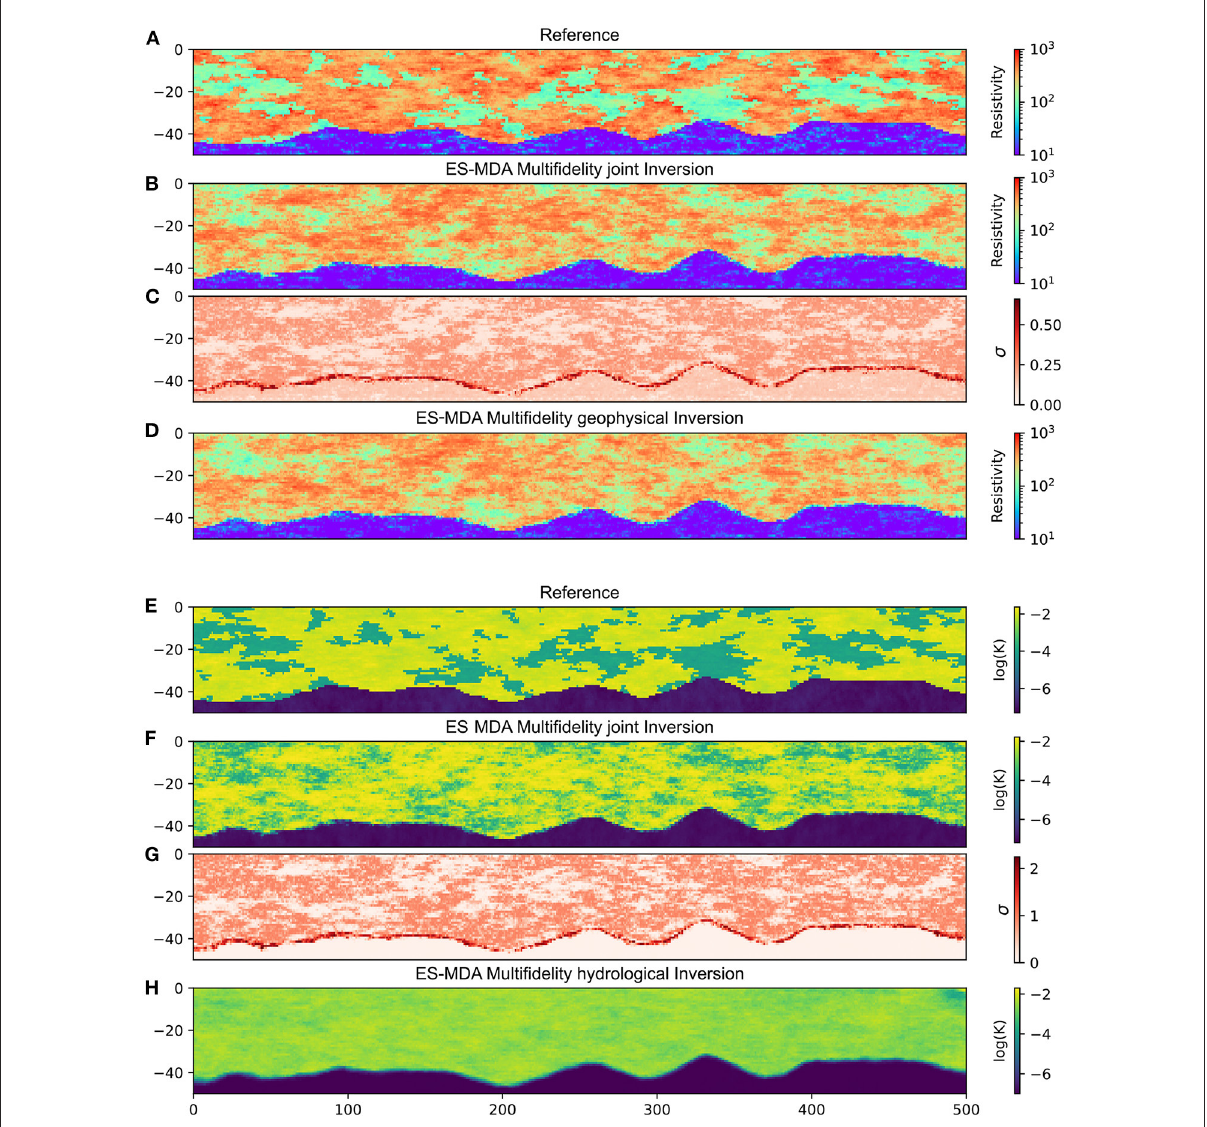
FIGURE7 High-fidelity results for case C1. (A) Reference resistivity field, (B) mean model of resistivity, (C) resistivity uncertainty, (D) mean model for an application of the ES-MDA algorithm only using resistivity data, (E) permeability reference, (F) mean model of permeability, (G) permeability uncertainty, and (H) is the mean model for an application of the ES-MDA algorithm only using hydrological